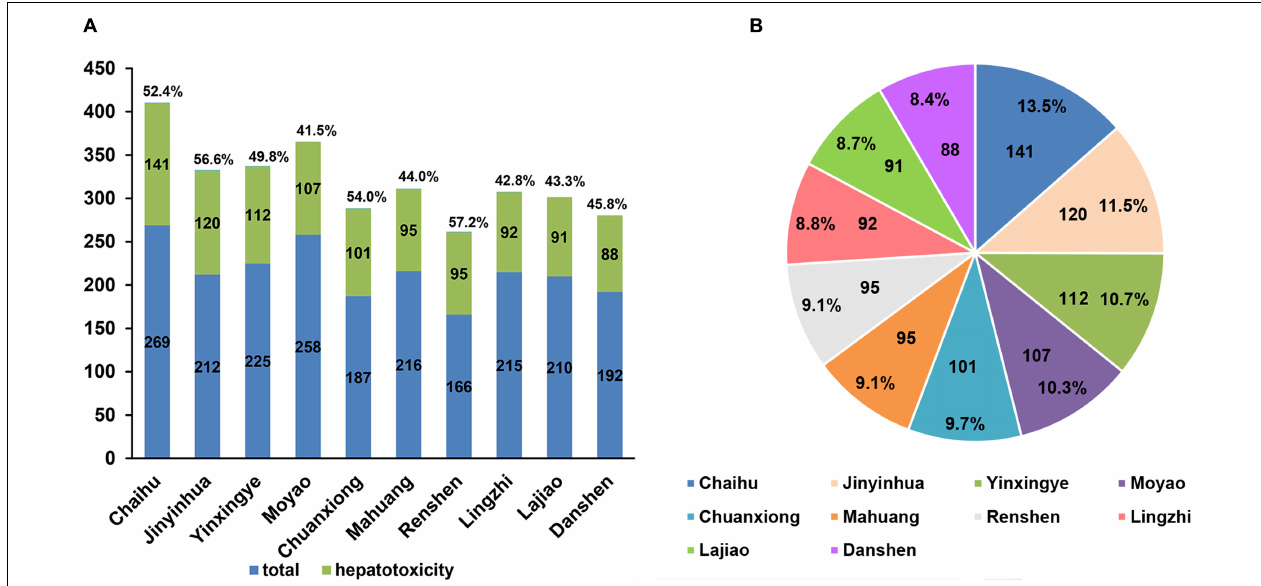
FIGURE 3 | The top 10 herbs with the highest number of hepatotoxic compounds as well as the corresponding proportions of hepatotoxic ingredient numbers to the number of compounds in each herb (A) and the corresponding proportions of the predicted hepatotoxic compounds for each herb to the total 1,042 hepatotoxic compounds of top 10 herbs (B)